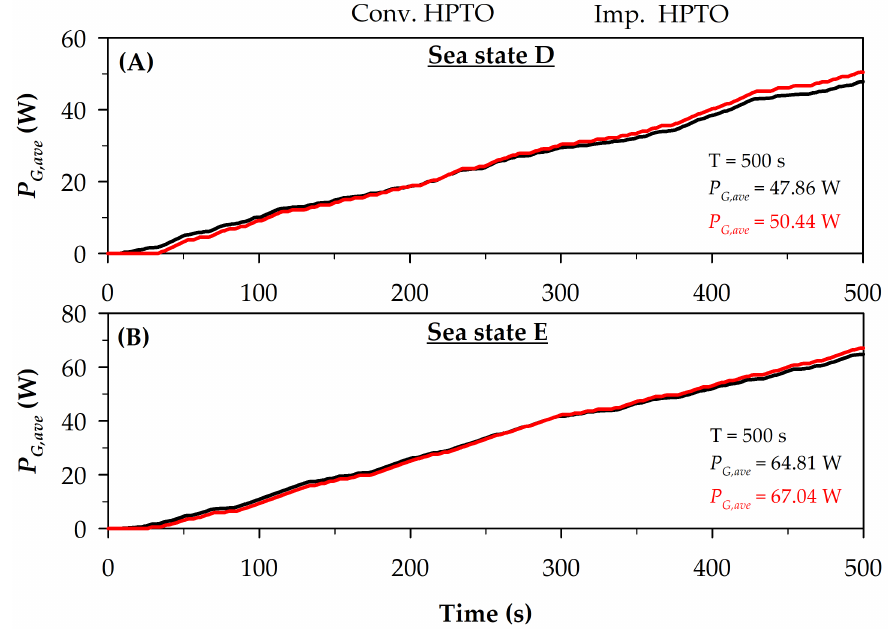
Figure 24. The average P G , conv . and P G , imp . for the different significant wave period